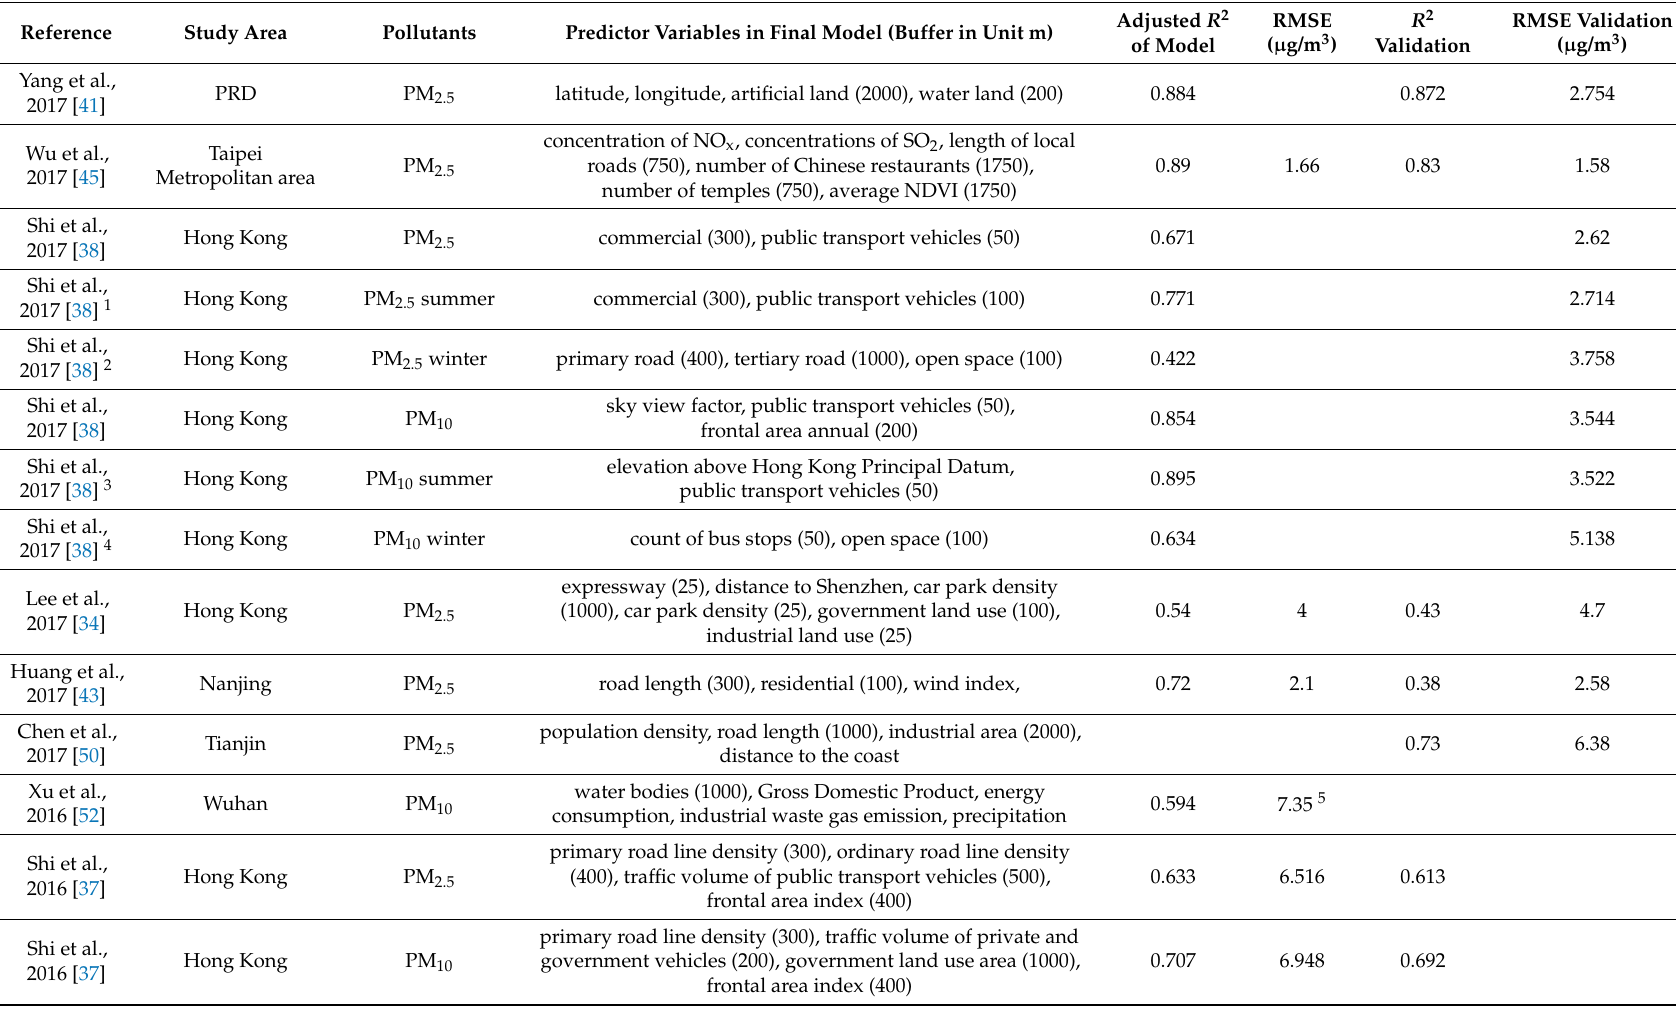
Table 5. Predictor variables and performance statistics of land-use regression models for annual-average PM 2.5 /PM 10 concentrations in